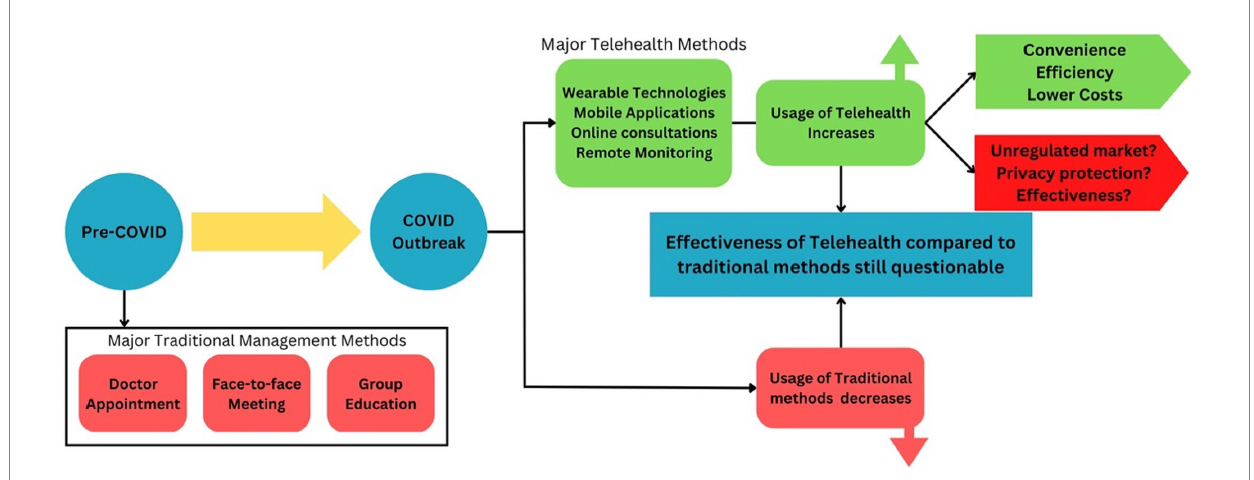
FIGURE 1 The shift of chronic disease management method after COVID-19 outbreak. Following the outbreak of COVID-19, there was a significant increase in the use of telehealth, which brought convenience and benefits to patients, but also raised several concerns, such as an unregulated market, privacy protection, and the effectiveness of telehealth. Simultaneously, the use of traditional chronic disease management methods has decreased significantly. Whether or not telehealth can truly replace traditional methods remains to be determined, in addition to the effectiveness of each